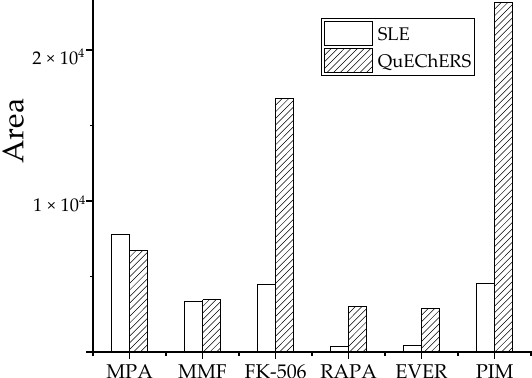
Figure 6. Effect of two pretreatment methods on recovery peak area of analyte.